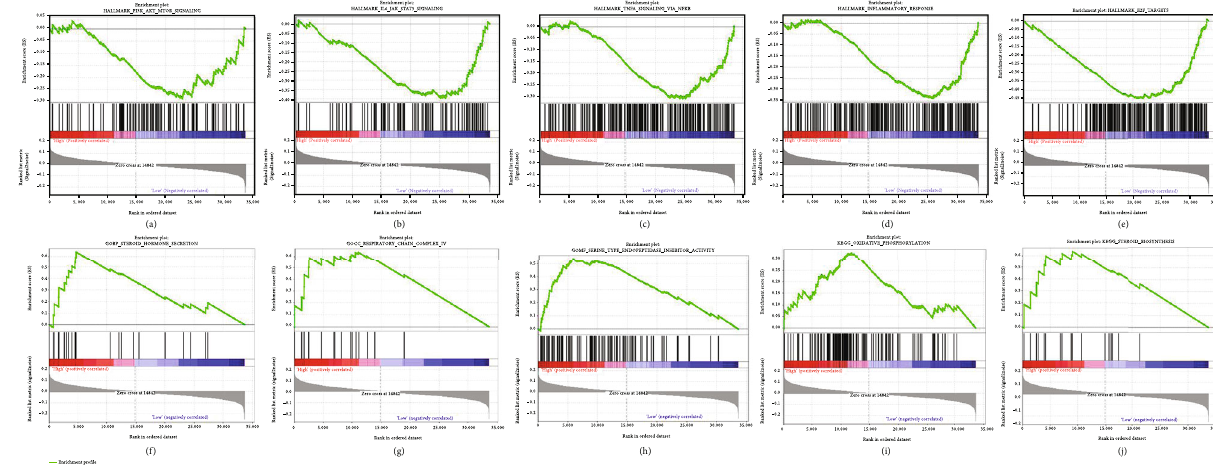
Figure 7: Gene enrichment analysis of ferroptosis-related lncRNA based on